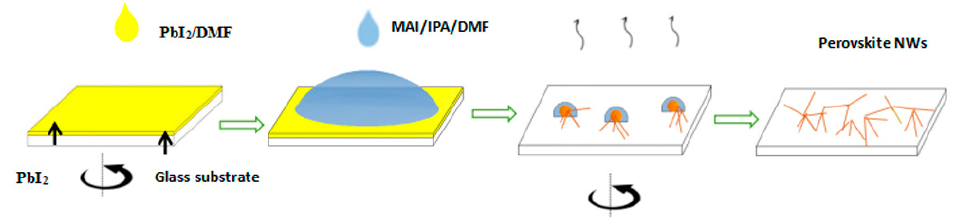
Figure 1. The schematic illustration of the two-step spin-coating process. Firstly, PbI 2 -DMF precursor solution was spin-coated onto a SiO 2 /Si substrate to form PbI 2 thin films, followed by dripping